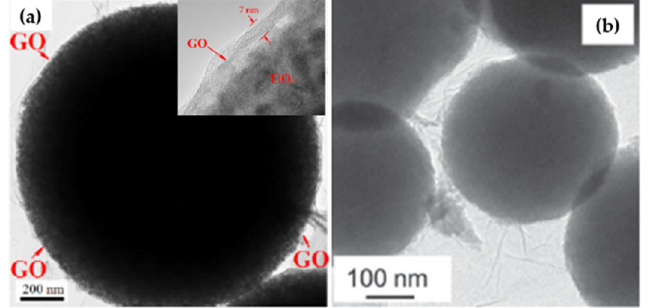
Figure 2. TEM images of ( a ) GO-wrapped TiO 2 microspheres [56] and ( b ) core-shell structured TiO 2 /GO [58].